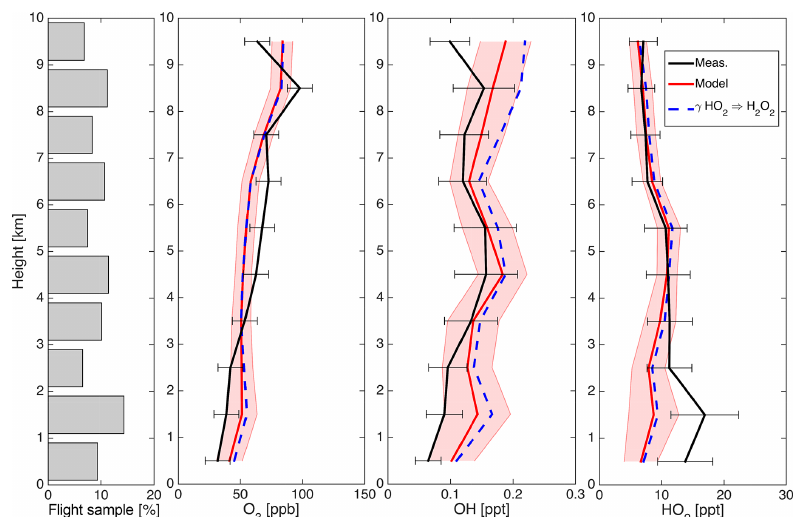
Figure 6. Vertical profiles of mean modeled (red) and measured (black) ozone, OH, and HO 2 for ARCTAS-B flight data binned by kilo- meter. Gray bar graph shows percent of flight data within each vertical bin. Shaded regions represent 1 σ of model ensemble; error bars on measurements are uncertainty at 1 σ confidence. The blue line represents gamma HO 2 producing H 2 O 2 rather than H 2 O.